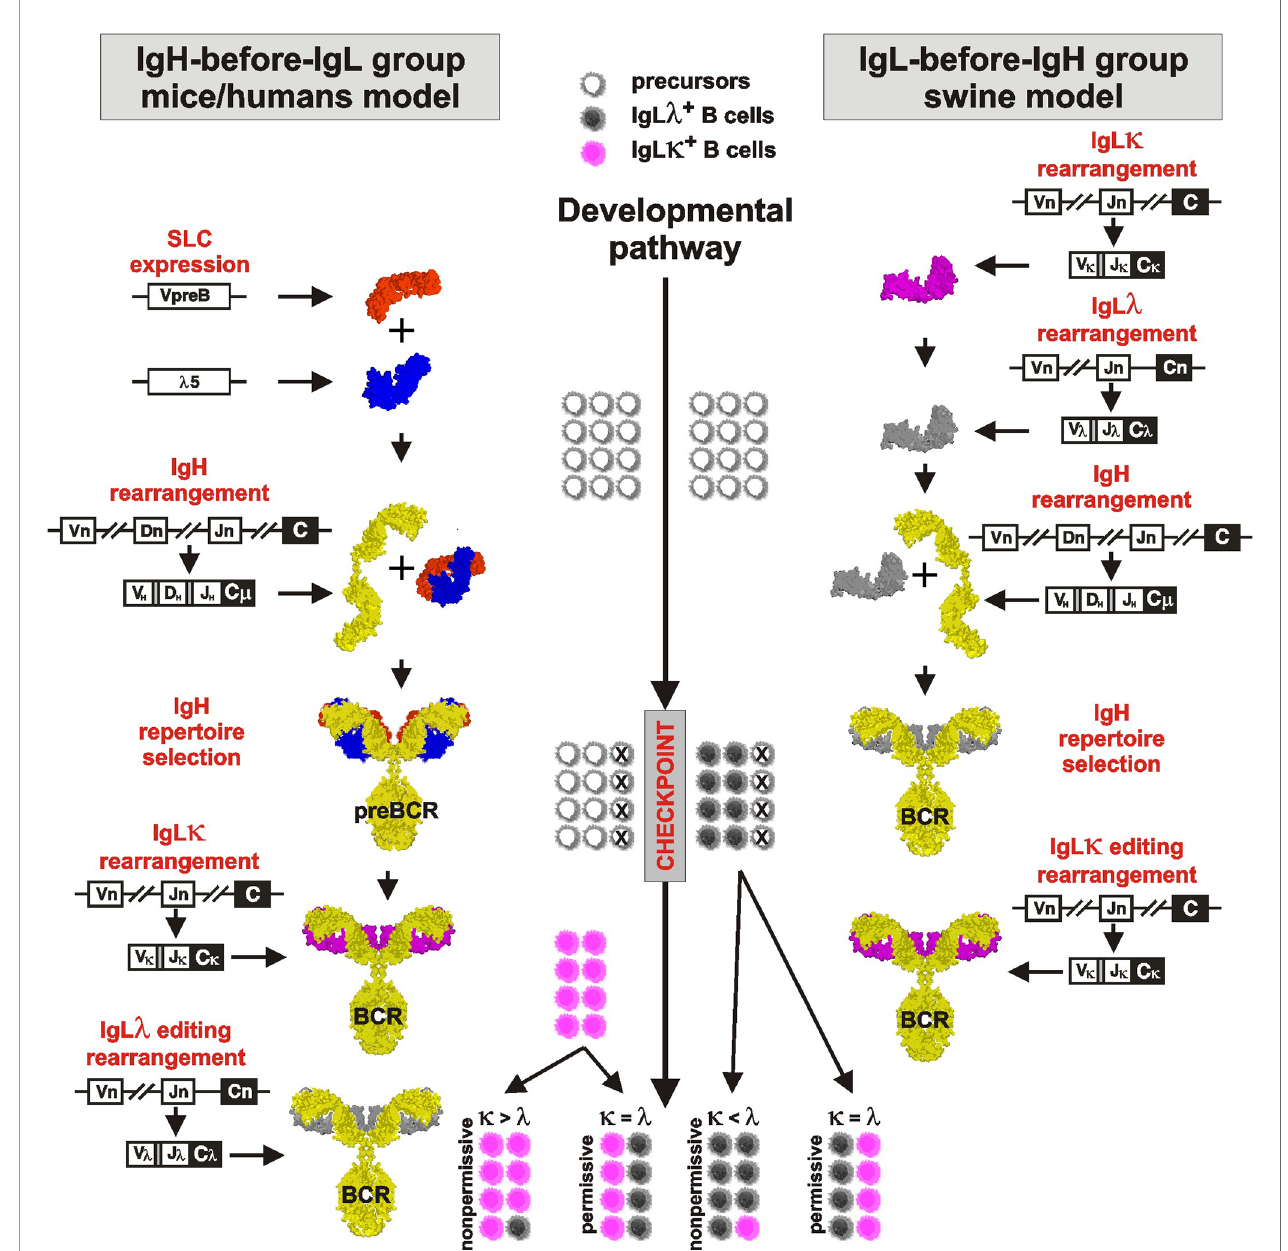
FIGURE 1 | Proposed comparative model of B cell development in species rearranging IgH before IgL (left part) and IgL before IgH (right part). The critical checkpoint is indicated on the middle developmental line. Differently colored cells near the developmental line are for illustration only and indicate the proportional outcome of B cell development with respect to IgL l + (gray) and IgL k + (pink) B